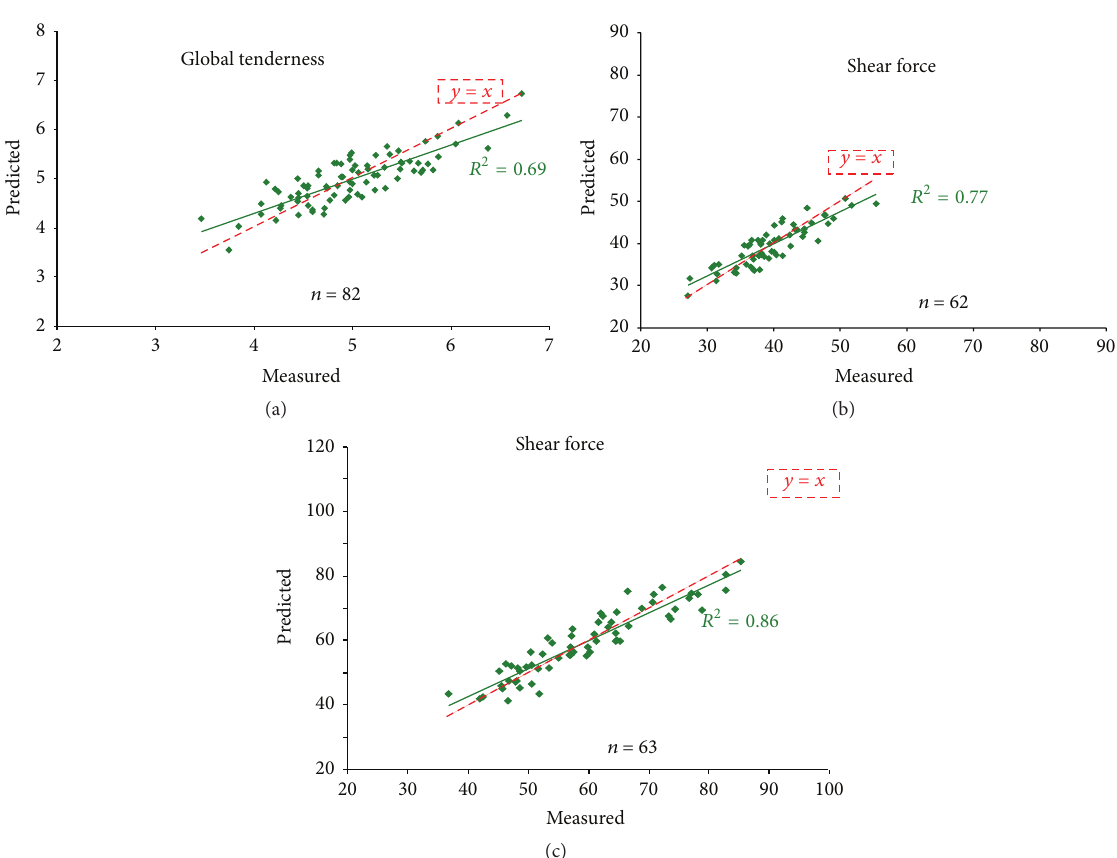
algorithm to compute prediction values based on equations of